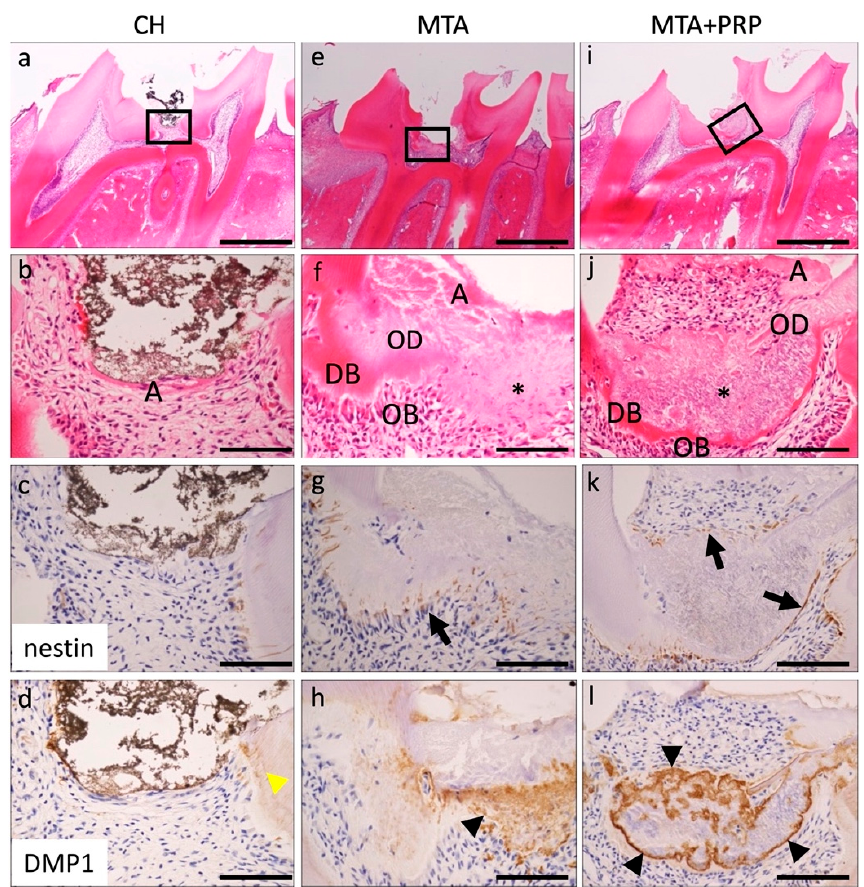
Figure 3. Histological findings of the pulp tissue at 7 days after pulp capping with CH ( a – d ), MTA ( e – h ), or MTA + PRP ( i – l ). Necrotic or amorphous layers ( A ) were observed at the exposed side of the dental pulp with few inflammatory infiltrations ( b , f , j ). In the deep layer of pulp capping with MTA and MTA + PRP, the fine granular extracellular matrix (*) and eosinophilic DB or OD with OB lining were observed. Nestin was negative in CH ( c ); however, apparent nestin-positive OBs were lined under the DB in MTA and MTA + PRP ( g , k , black arrows). DMP1 was only localized in the dentinal tubes of the primary dentin in CH ( d , yellow arrowhead). However, a prominent DMP1 -positive matrix was observed along with the outer layer of the DB in the MTA and MTA + PRP ( h , l , black arrowheads). DB, dentin bridge; OD, osteoid dentin; OB, odontoblast; Scale bars: 1 mm in ( a , e , i ); 100 µm in ( b – d , f – h , j – l ).